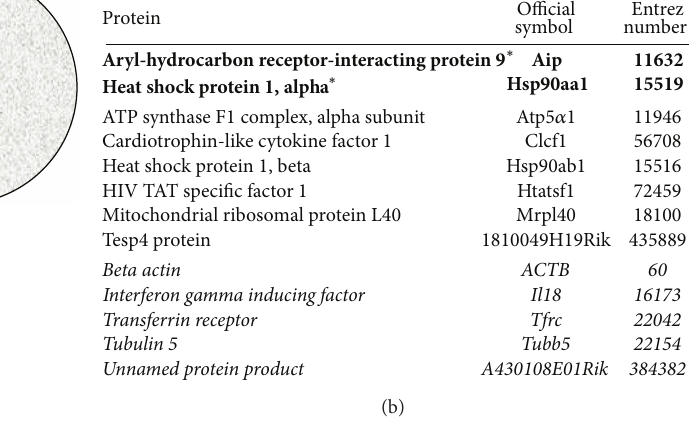
Figure 2: DMSO control data set. (a) Venn diagram of proteins identified by mass spectrometry in 3 data sets of AHR-TAP DMSO (0.01%) control. (b) Table listing of proteins identified in two out of three data sets. Bold type with ∗ denotes a protein represented in all three data sets. Italicized type denotes nonspecific proteins identified in both AHR-TAP and GFP-TAP samples.